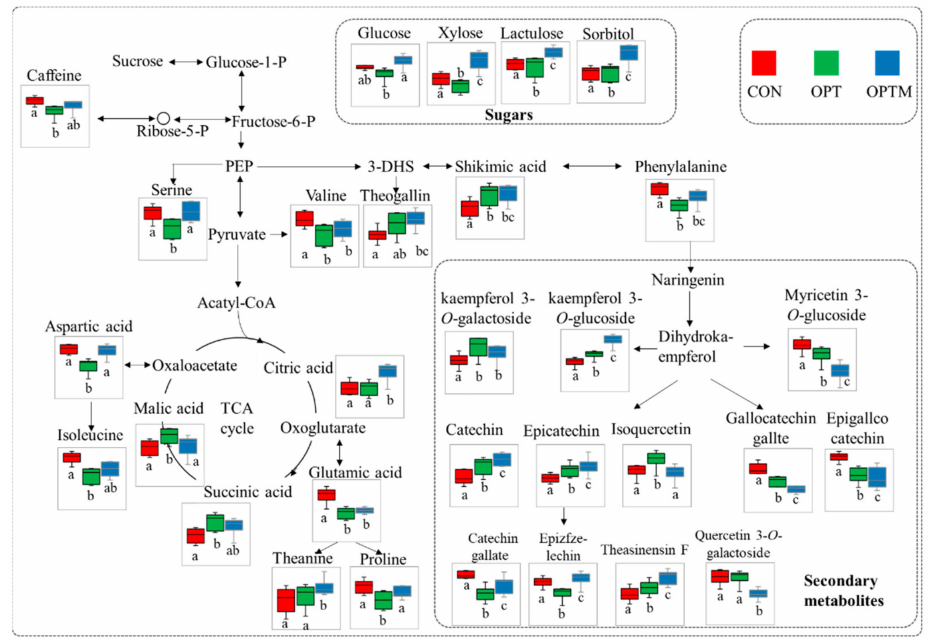
Figure 4. Schematic illustration of metabolic pathways affected in tea samples under three different treatments. Different letters (a, b, c) within the same box plot indicated significant differences between treatments ( p <